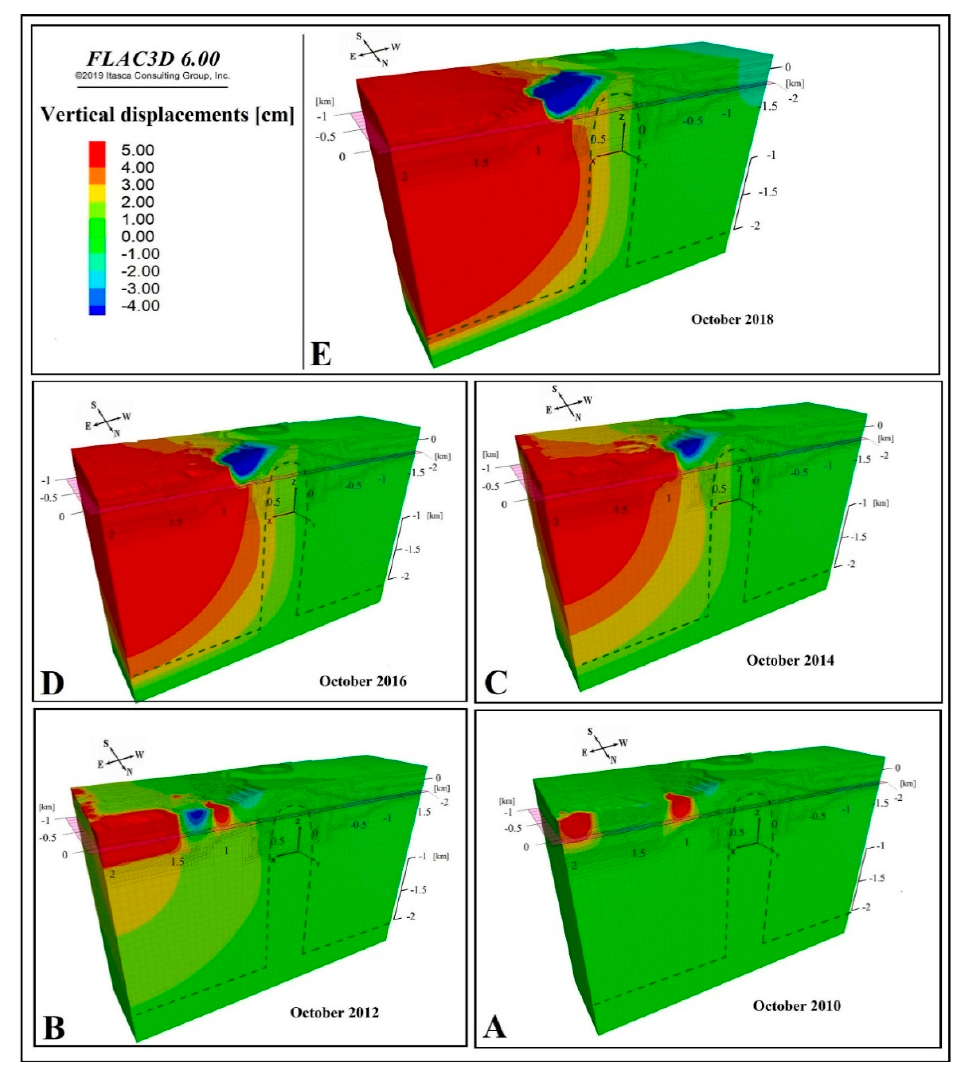
Figure 10. The vertical displacements in the analyzed area: a positive value means uplifting; a negative value means subsidence.